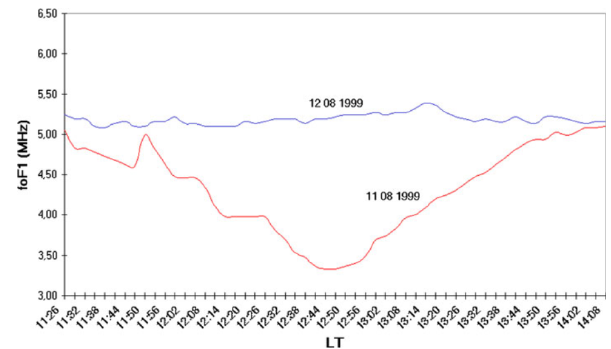
Figure 14. Variation of the critical frequency of the F1 layer foF1 during the total solar eclipse of 11 August 1999 and in the same interval on the next day observed in the Geophysical Observatory Nagycenk, Hungary. (Re-printed from Sátori et al., 2013, Fig. 22.)